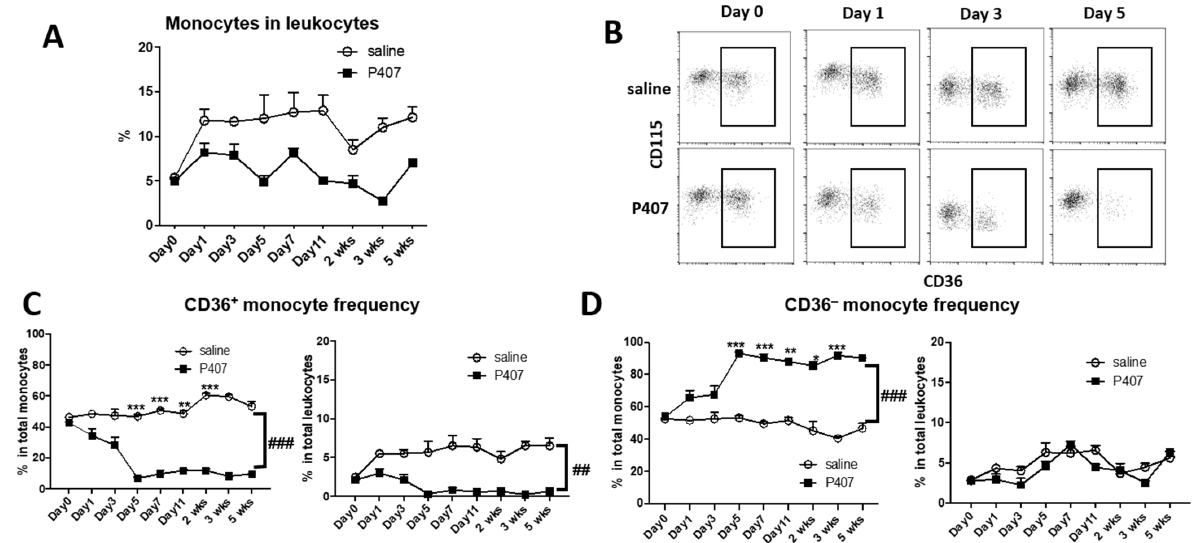
Figure 4. Changes in the proportions of monocytes and subsets in Ldlr − / − mice with P407 injection. ( A ) Changes in percentages of total monocytes in total leukocytes in Ldlr − / − mice with injection of P407 or saline control. ( B ) FACS examples showing rapid and profound reductions in CD36 + , but not CD36 – , monocytes in Ldlr − / − mice with P407 injection. Changes in percentages of ( C ) CD36 + and ( D ) CD36 − monocytes in total monocytes or in total leukocytes in Ldlr − / − mice with injection of P407 or the saline control. n = 7 mice/group. Data are shown as mean ± SEM and were analyzed by two-way ANOVA with repeated measures and assumption of inequivalence of variance, followed by Š í d á k’s multiple pairwise comparisons test. * p < 0.05, ** p < 0.01, and *** p < 0.001 for comparisons between P407 and control groups. ## p = 0.01 and ### p < 0.001 for group x time interaction